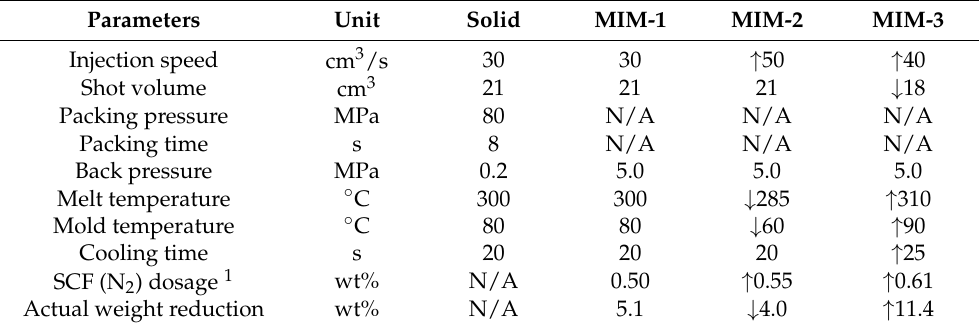
Table 1. Four molding trials and sample types as well as the corresponding processing parameters. Up and down arrows indicate the adjustment compared to the solid injection molding setting or